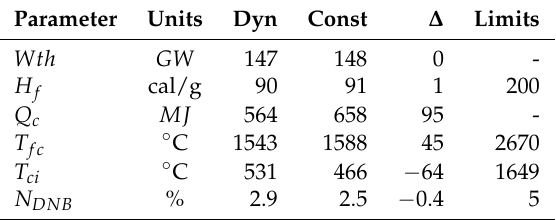
Table 4. Peak safety parameters for constant and dynamic pellet-cladding gap HTC, R tol =